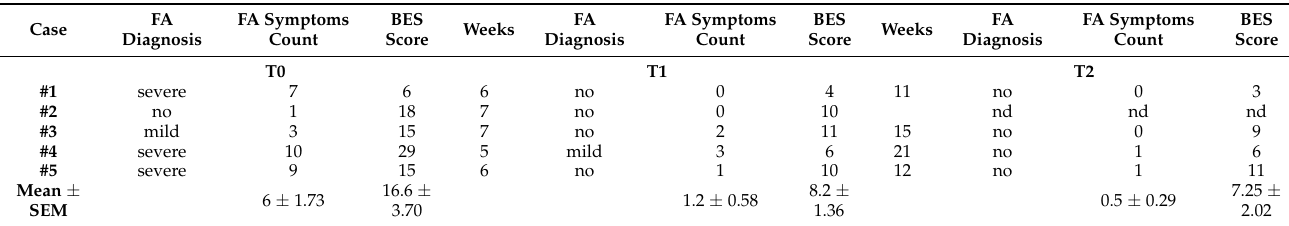
Table 1. Results of food addiction (FA) and binge eating scale (BES) questionnaires in the 5 subjects. Food addiction diagnosis is reported in 4 levels (no, mild, moderate, severe). Weeks refer to the time of observation. Case